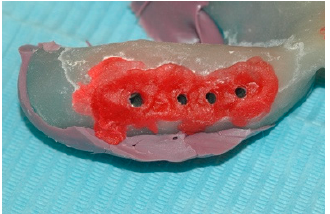
Figure 6. Impression and structure made.